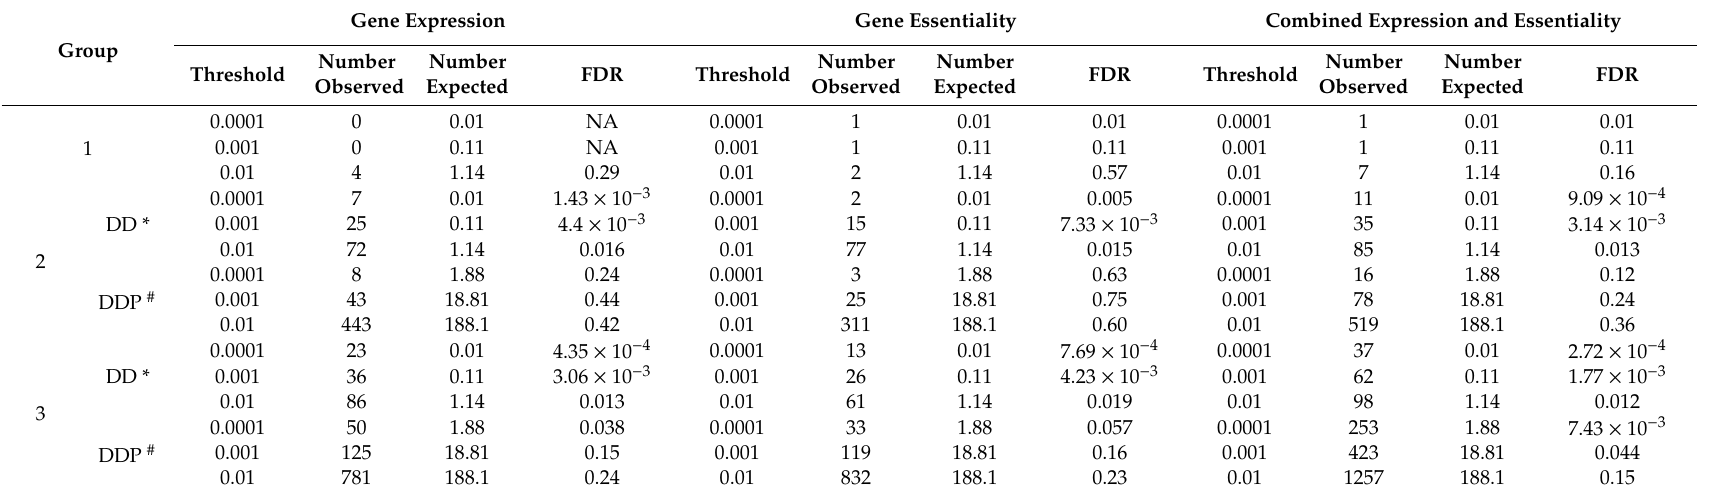
Table 2. Results of pathway